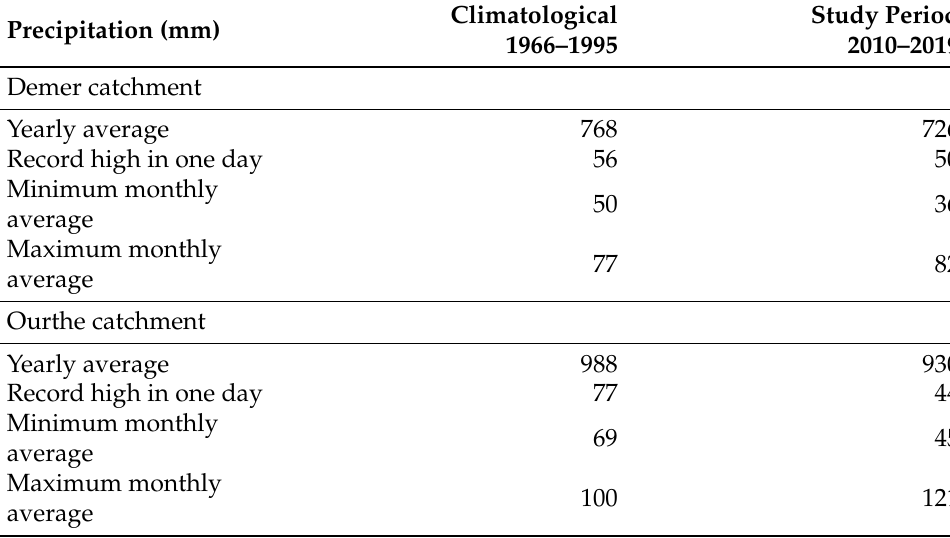
Table 2. Synoptic precipitation climatology (totals, areal